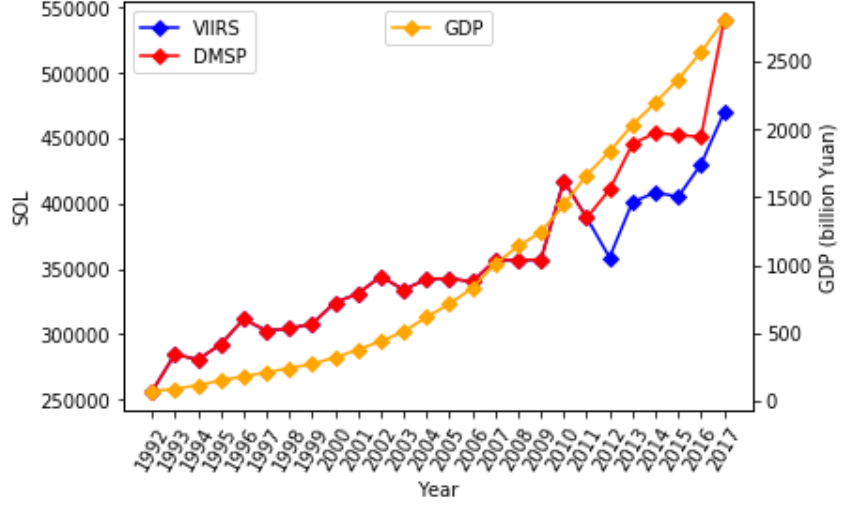
Figure 11. SOL of NTL and gross domestic product (GDP) of Beijing in 1992–2017.